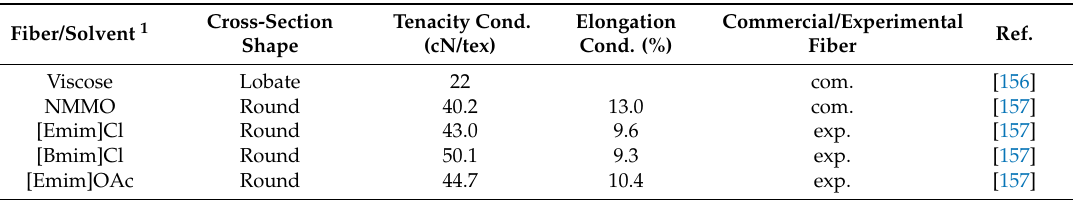
Table 3. Comparison of mechanical properties of regenerated cellulose fibers from viscose process [156] to NMMO and ILs